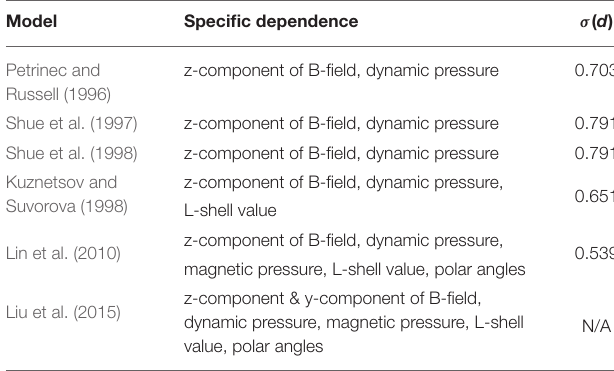
TABLE 2 | Summary of the Empirical Models with a list of solar-wind dependencies required for their